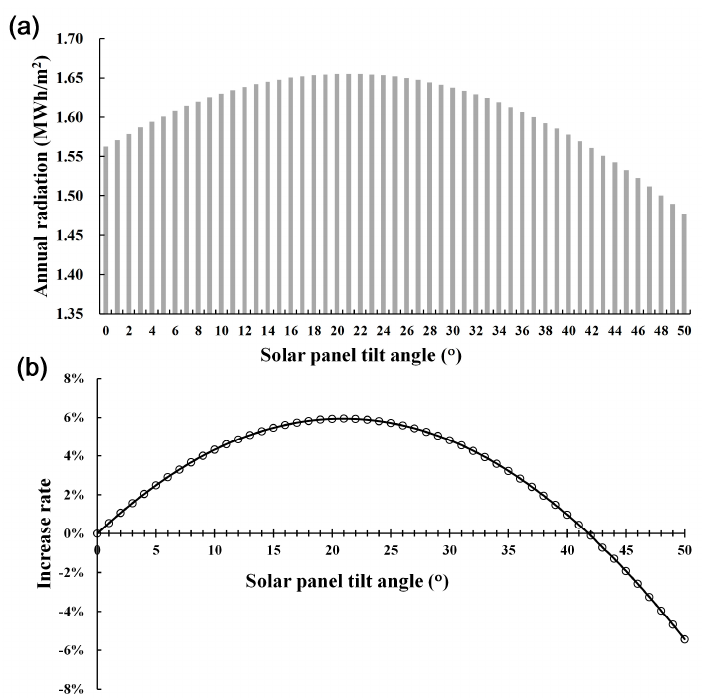
Figure 15. Results with a β ′ of 0–50°: ( a ) amount of total annual global irradiance, and ( b ) increase rate of the total annual global irradiance.